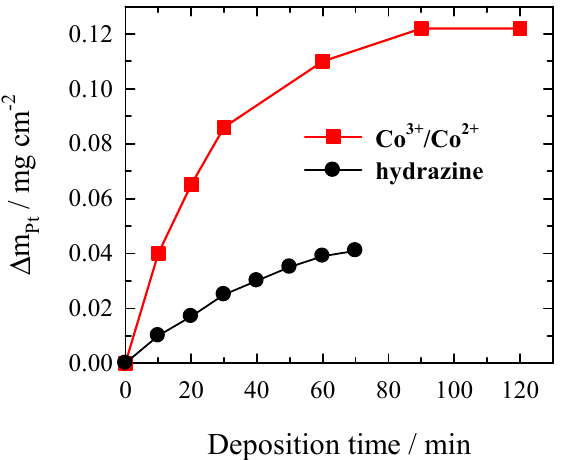
Figure 7. The rate of Pt deposition using different reducing agents.